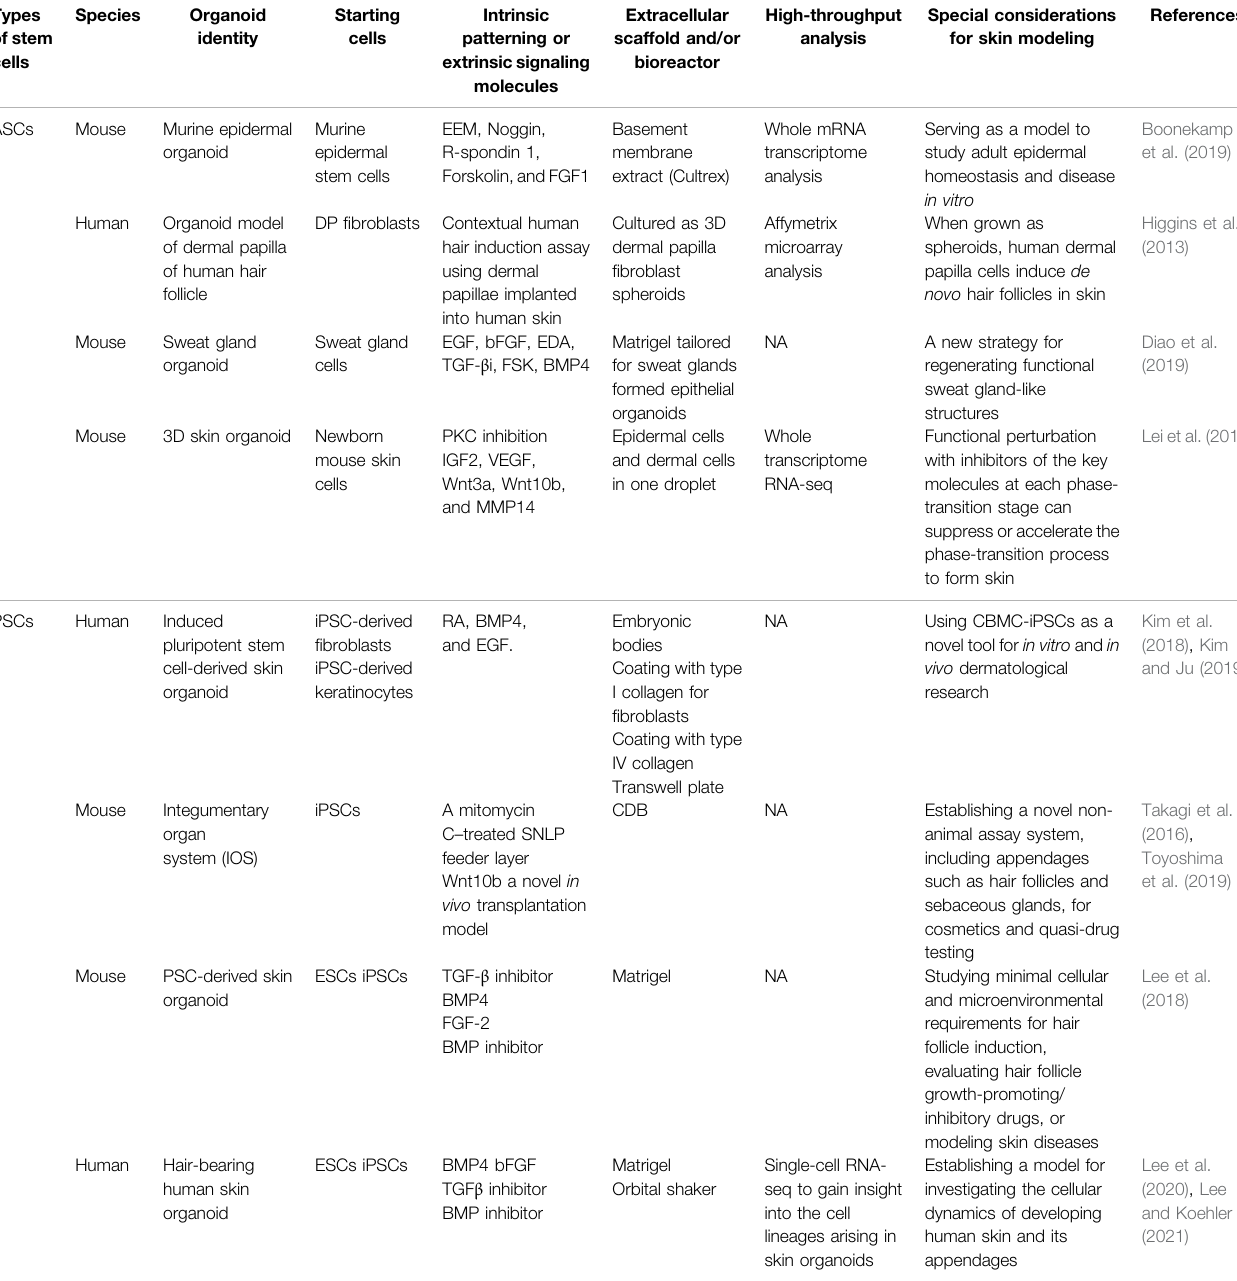
TABLE 1 | Overview of current skin organoid methods. A summary of important parameters in skin organoids, including types of stem cells, species, skin organoid identity, sourceofstartingmaterials,intrinsicpatterningorextrinsicsignalingmolecules,extracellularscaffoldand/orbioreactor,whethertousehigh-throughputsequencingand special considerations for skin modeling. ASCs, Adult stem cells; BMP4, Bone Morphogenetic Protein 4; CDB, Clustering-dependent embryoid body; DP, Dermal papilla; EBs, Embryonic bodies; EEM, Epidermal expansion medium; PSCs, Pluripotent stem cells; RA, Retinoic Acid; TGF- β i, TGF- β signaling inhibitor; 3D,